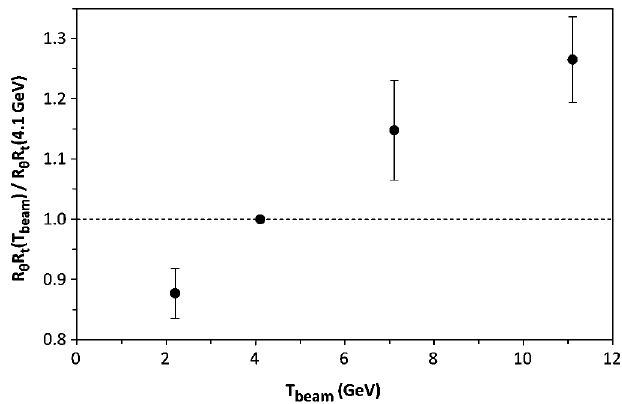
FIG. 8. Combined correction R (cid:2) for the unmeasured region, (cid:2) < 350 mrad , and R t for the effect of hadronic shower develop- R ment in a 2 (cid:6) target, relative to the correction at 4.1 GeV.